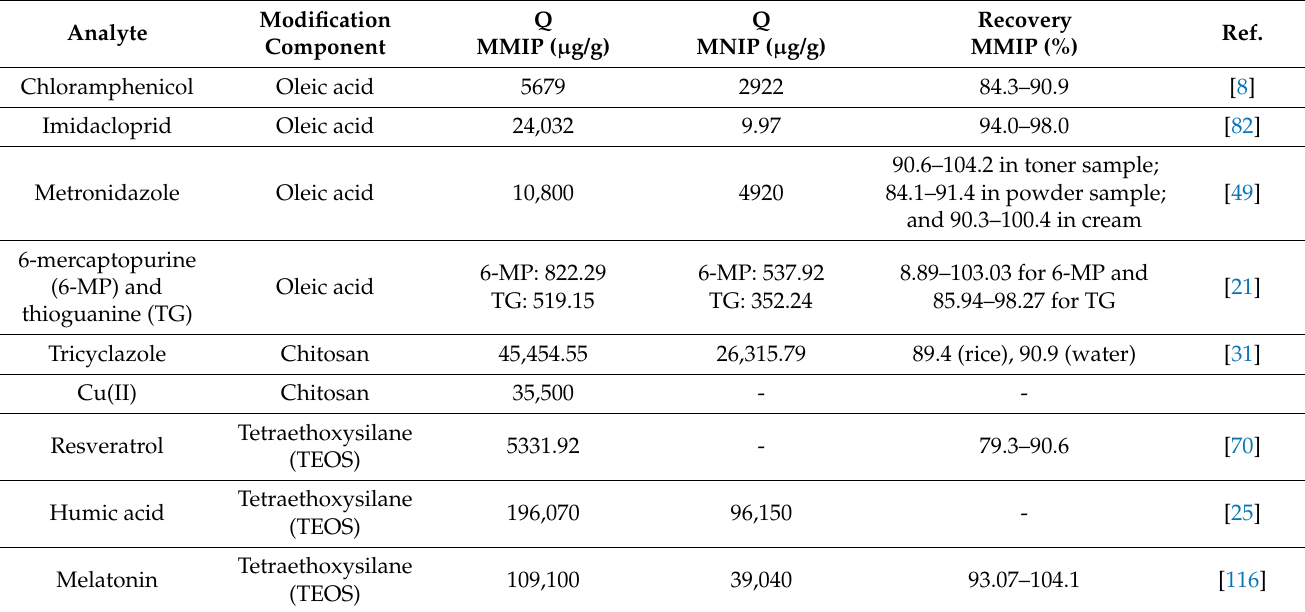
Table 5. Summary of MMIP methods using modified